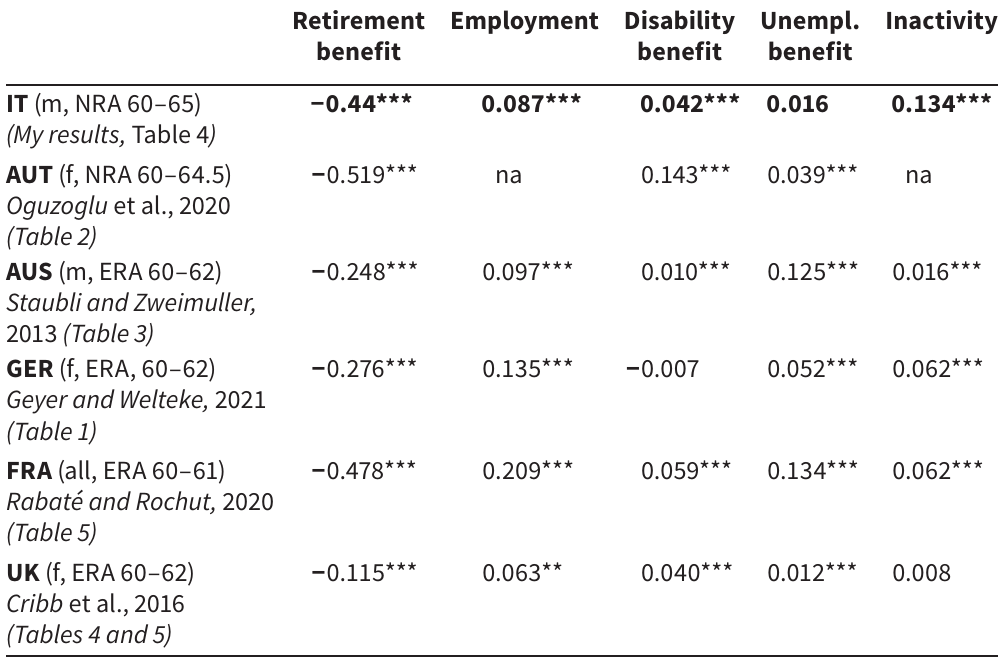
Effect of rising ERA/NRA on different labor market outcomes: comparison of previous studies Retirement Employment Disability Unempl. benefit benefit